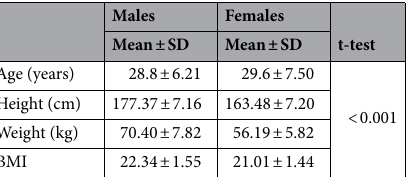
Table 1. Anthropometric measures of the sample. t-test according to Student